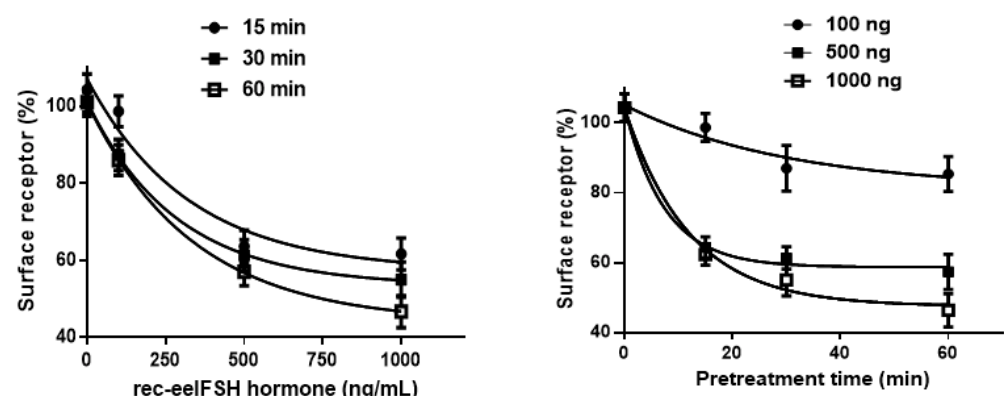
Figure 5. Time course and dose-dependence of the cell surface expression of wild-type eelFSHR. HEK-293 cells were transiently transfected with wild-type eelFSHR plasmid. The cells were incubated with recombinant eelFSH (rec-eelFSH) (100, 500, and 1000 ng / mL) for up to 60 min. The cell surface expression of the receptor in the non-pretreated cells was taken as 100%, as described in the Materials and Methods section. The results are expressed as the means ± SE of three independent experiments.